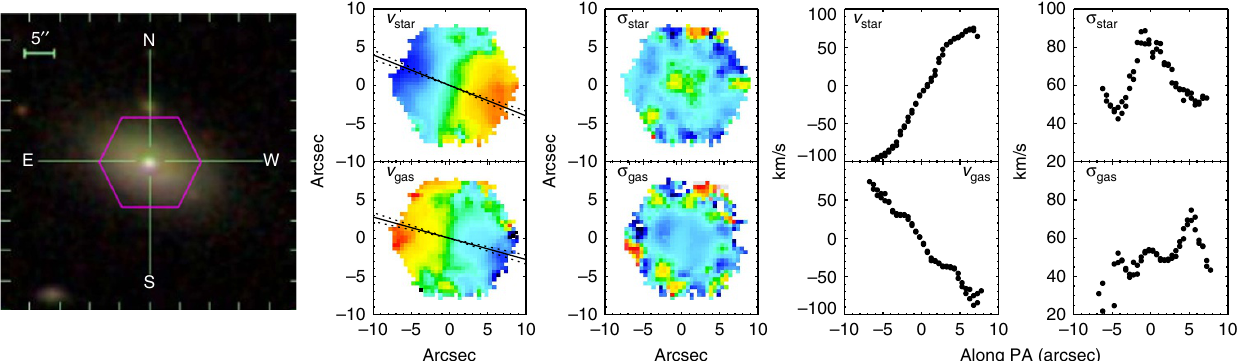
Figure 1 | An example of a blue star-forming counter-rotating galaxy. The left panel shows the SDSS g , r , i —band image, the projected velocity fields of stars (top) and gas (bottom) are shown in the second column, while the third column shows the velocity dispersion maps of stars and gas. The projected velocity and velocity dispersion along major axis (black solid line in the second column) are shown in the last two columns. Dashed black lines represent ± 1 s uncertainties in the major-axis position